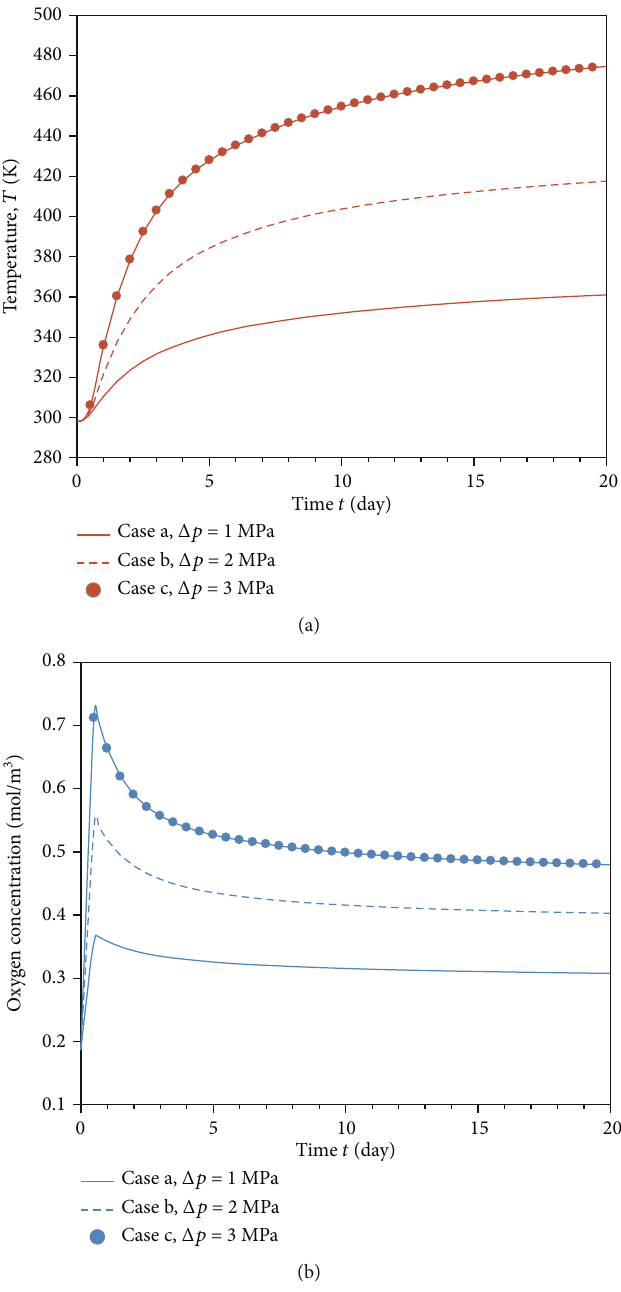
Figure 7: The evaluation of temperature and oxygen concentration with di ff erent pressure di ff